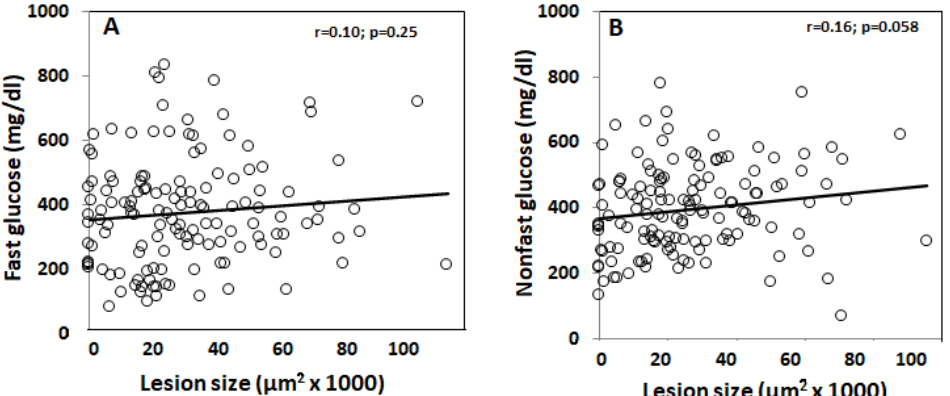
Figure 5. Associations of carotid lesion sizes with fasting ( A ) and non-fasting plasma glucose levels ( B ) among male F2 mice. Each circle represents values of an individual F2 mouse. The correlation coefficient ( r ) and significance ( p ) are shown.